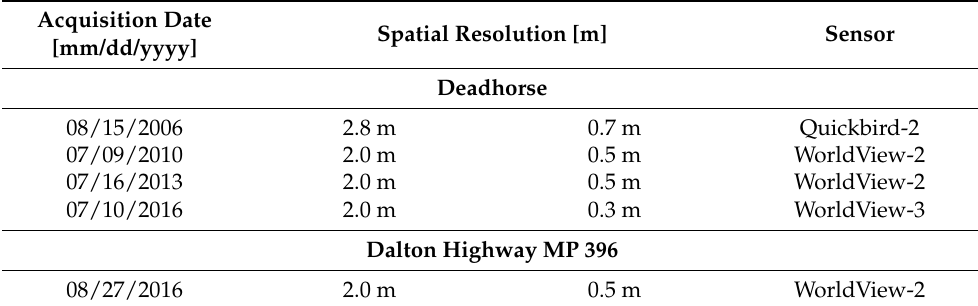
Table 1. Image acquisition date, spatial resolution of the multi-spectral and panchromatic bands and sensor